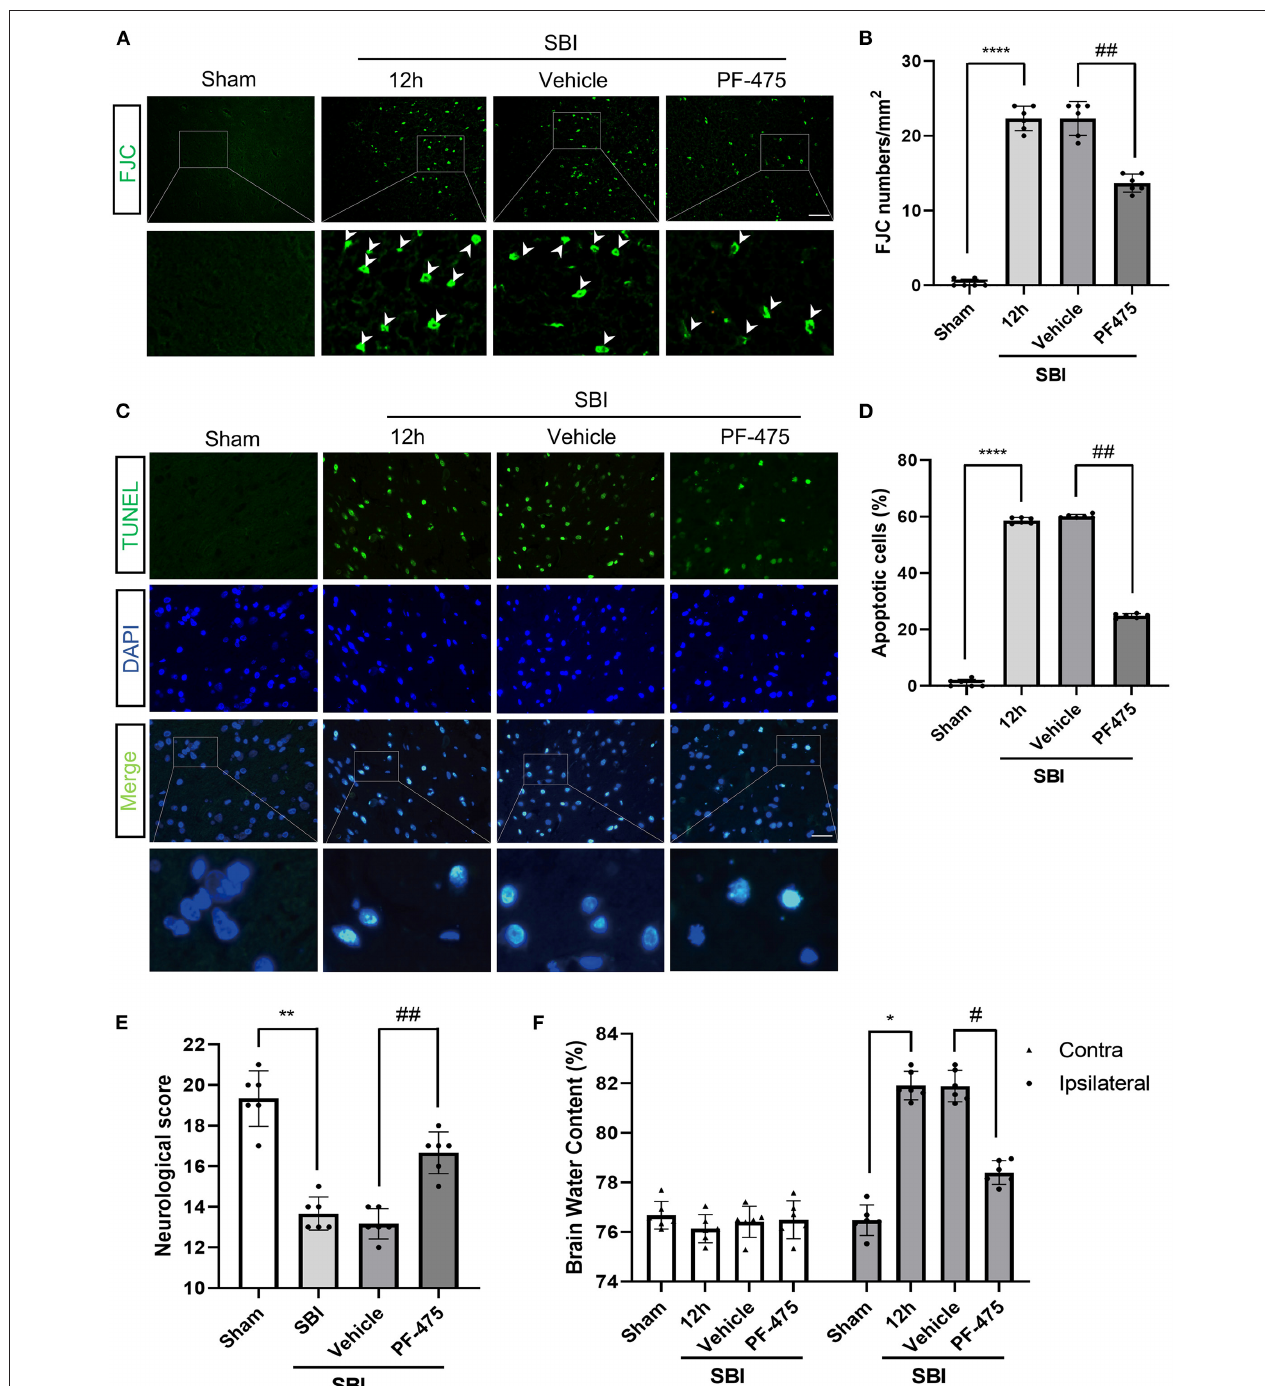
FIGURE 4 | Effects of PF-475 intervention on cortex injury 12h after SBI. (A,B) Neuron necrosis was detected by FJC staining. FJC-positive cells/mm2 was quantified. (C,D) Neuronal apoptosis was detected with the TUNEL assay. TUNEL-positive neurons were quantified. Bar = 50 µ m, N = 6. (E) Neurological behavioral scores in SBI rats after PF-475 intervention. (F) The brain water content of the bilateral hemispheres of the different groups was measured using the wet-dry method. Data = mean ± SD, n = 6. * P < 0.05, ** P < 0.01, **** P < 0.001 vs. Sham; # P < 0.05, ## P < 0.01 vs. SBI + PF-475.